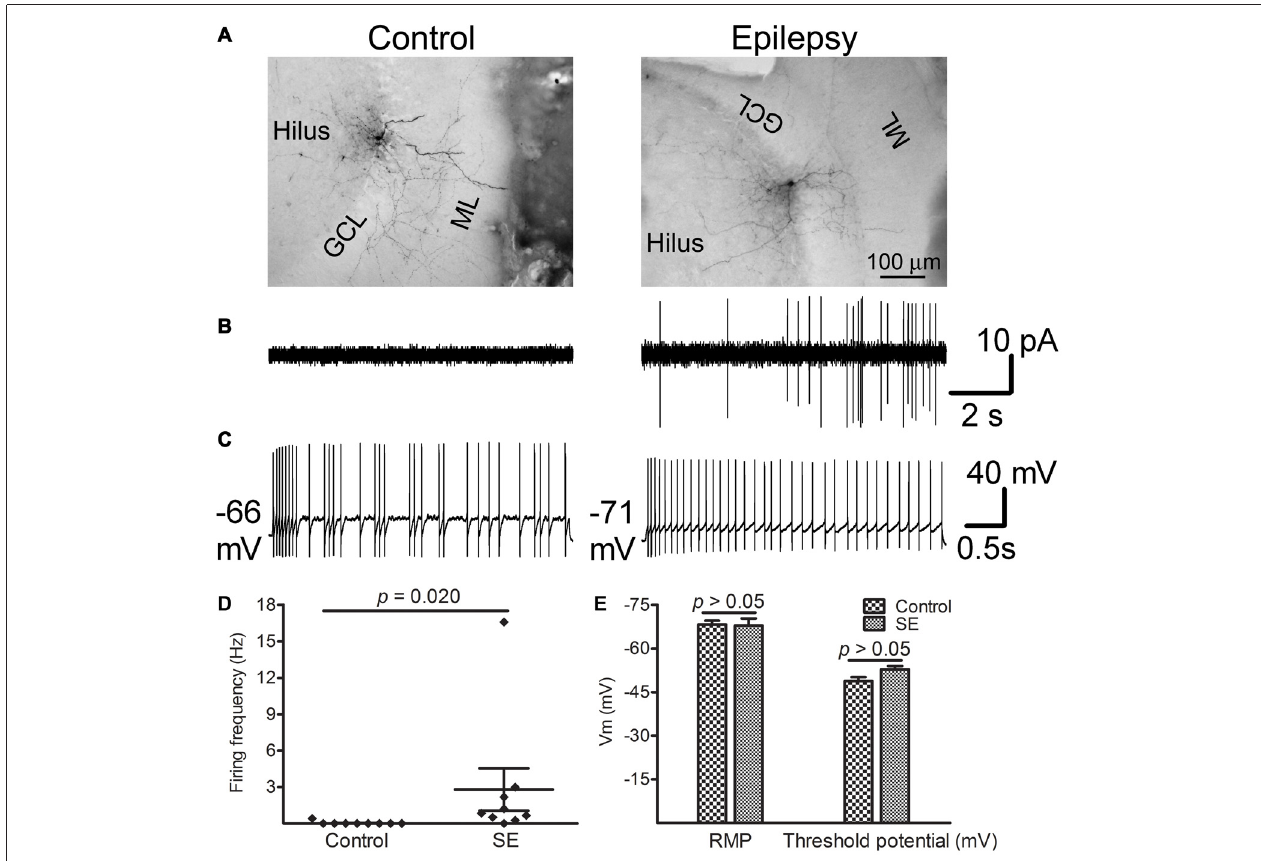
FIGURE 6 | Spontaneous and evoked firings recorded from morphologically identified hilar interneurons near the border of the granule cell layer and the hilus more than 10 weeks after SE . Patch recordings were made in interneuron-like cells along the border between the granule cell layer and the hilus in vitro . After seals ( > 2 G Ω ) were made, currents were recorded in cell-attached mode by holding cells at − 60 mV for 5 min. Thereafter, the membrane was ruptured and whole-cell recordings were conducted. Resting membrane potential (REM) was read immediately after break-in. The threshold potential for firing was determined from stepped current injection. (A) Morphologically developed biocytin-filled cells in which electrophysiological recordings were made. Note that both cells are TML cells. (B) Traces show spontaneous firing obtained from morphologically identified cells shown in (A) . (C) Evoked firing in the same cells shown in (A) in response to current injection. (D) Difference in spontaneous firing frequency between control and SE groups. Diamonds represent the firing frequency in individual cells. The longer horizontal lines indicate the mean and the shorter horizontal lines indicate error bars in each group. Statistical analysis was conducted with the Mann-Whitney test. (E) Bar graphs compare RMP and the threshold potential between the control ( n = 9) and SE ( n = 9) groups. Statistical analyses were performed via unpaired t